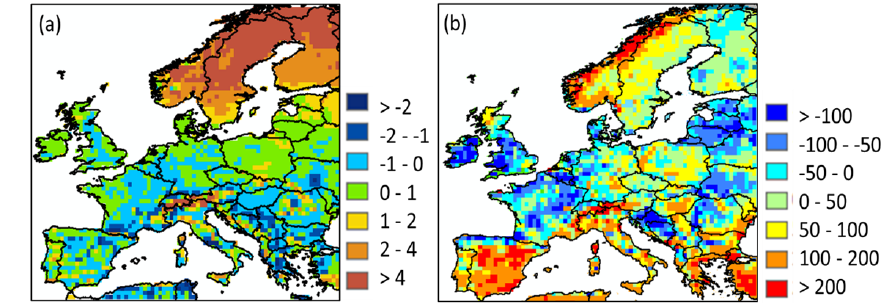
Figure 5. Difference in (a) simulated soil temperature (in ◦ C) against values reported by ERA5; (b) simulated soil heterotrophic respiration (in gCm − 2 ,yr − 1 ) against values reported by Yao et al. (2021).